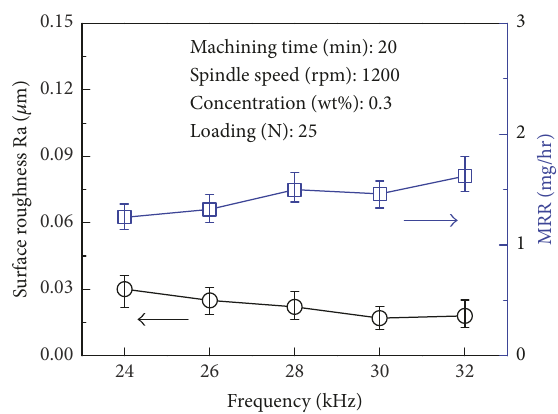
Figure 3: Impacts of vibration frequency on surface roughness.